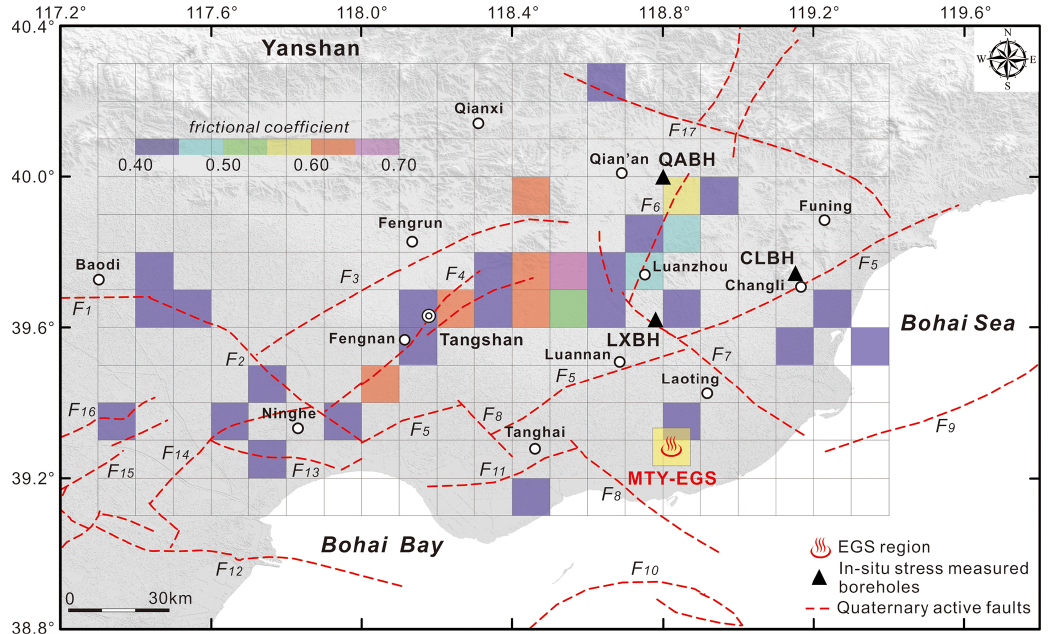
Figure 4. The critical coefficient of friction of the main seismic faults in the Tangshan seismic region, as determined by inversion of 98 focal mechanisms (seen in Fig. 2) using the STRESSINVERSE software package (Vavryˇcuk,